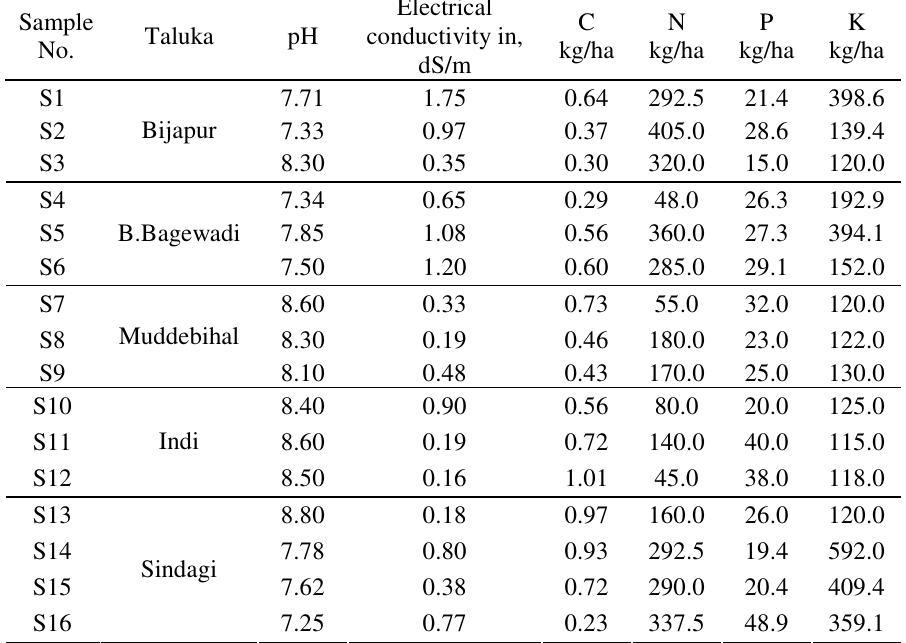
Table 1. Physicochemical parameters of soil of Bijapur